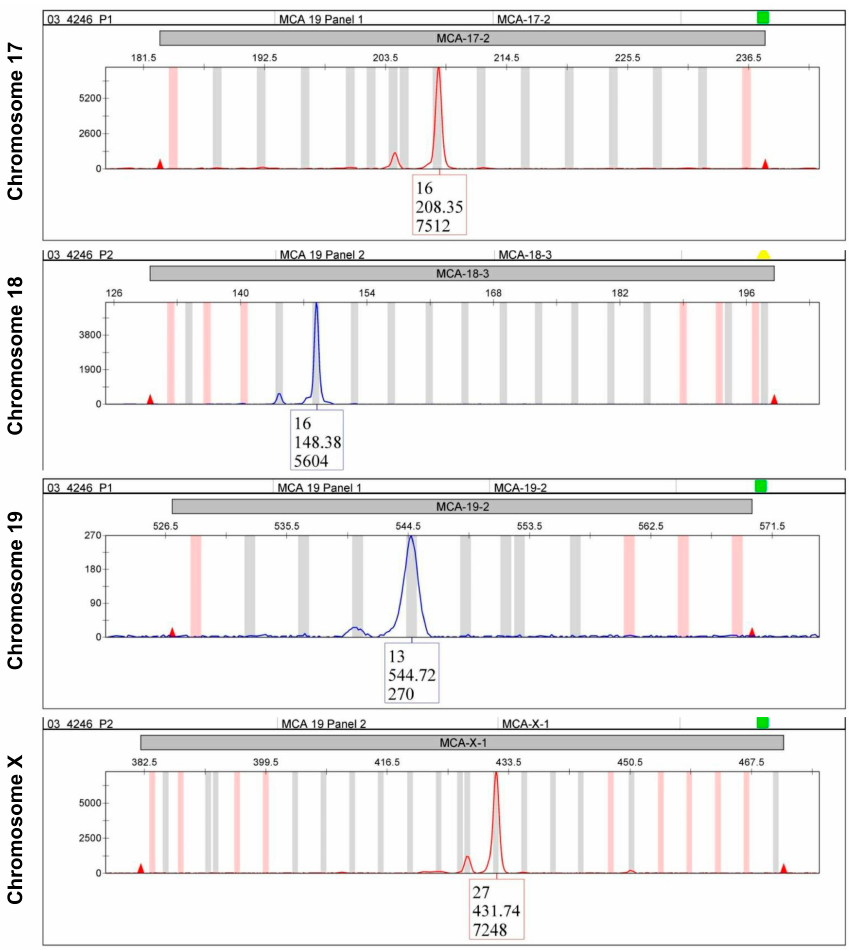
Figure 6. Chromatograms of typical short tandem repeat (STR) markers for a murine cell line. Genomic DNA from murine AML12 cells was isolated and subjected to STR profiling using the CellCheck TM Mouse system (IDEXX, Kornwestheim, Germany). This system amplifies 19 species-specific STR markers spread on 17 chromosomes. In this figure, four representative STR profiles from chromosomes 17, 18, 19, and chromosome X are depicted. For the complete STR profile of that cell line, refer to Table 5. Table 5. Analysis of 19 STR markers in three different mouse cell